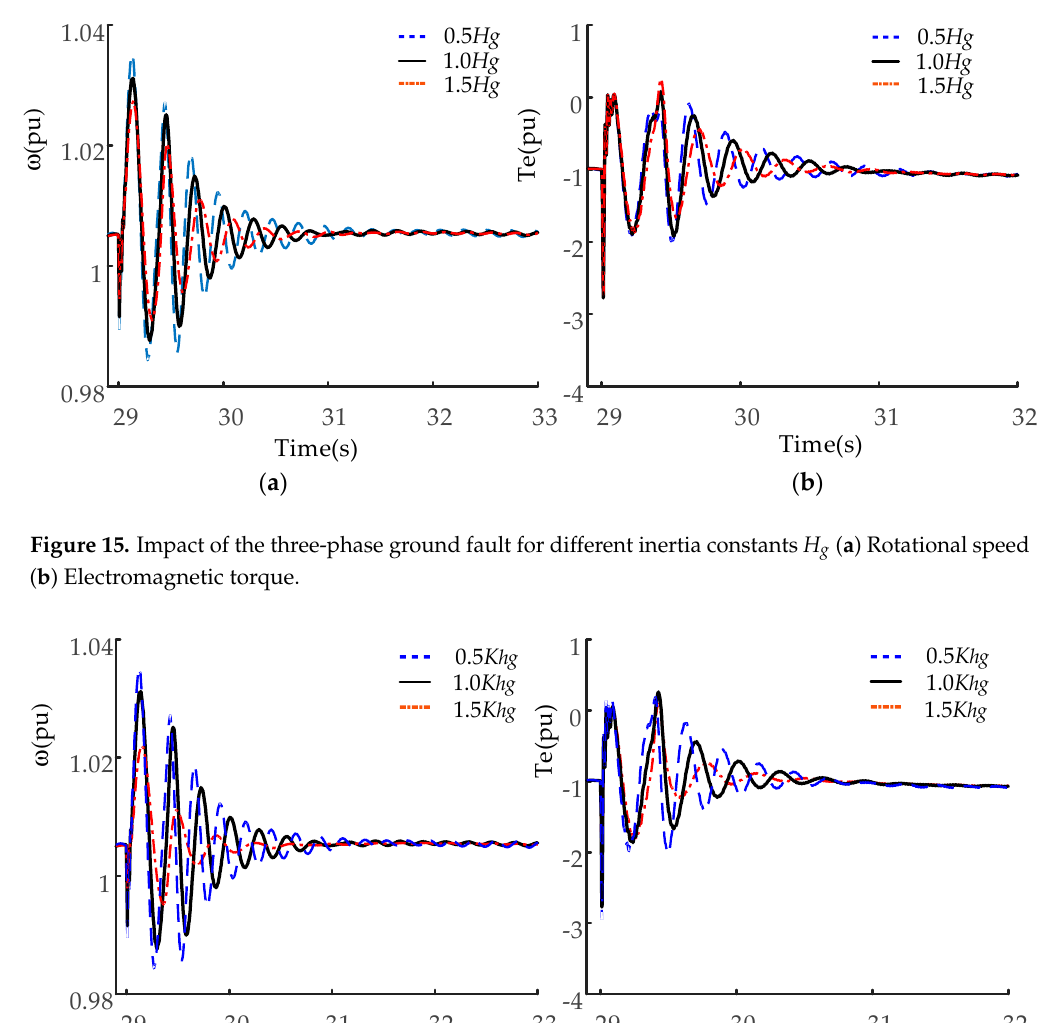
( b ) Figure 14. Impact of the three-phase ground fault for different wind farm capacity ( a ) Rotational speed ( b ) Electromagnetic torque.